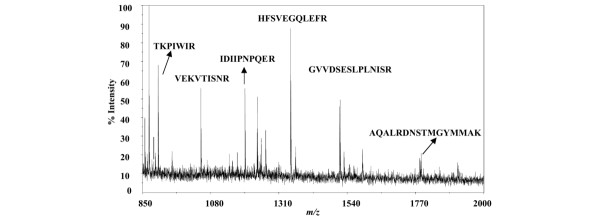
Peptide mass fingerprinting of in-gel tryptic digest of the 90 kDa band generated with a matrix-assisted laser desorption ionization-time-of-flight mass spectrometer. Protein bands indicated by the arrowhead in Fig. 1 were subjected to in-gel digestion and analyzed by mass spectrometry. The tryptic peptides from this band showed the presence of six peptides corresponding to heat shock protein 90 (Hsp90) as one of the proteins that were found in the altered protein-protein interaction pattern of p53 with and without PRIMA-1 treatment.